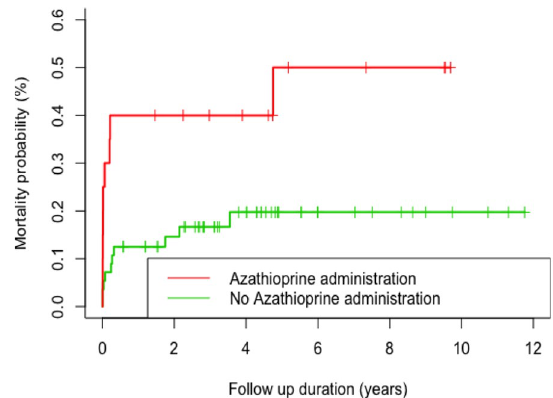
Fig. 1 Outcome of IBD patients admitted to the ICU according to pre‑ cious treatment with azathioprine